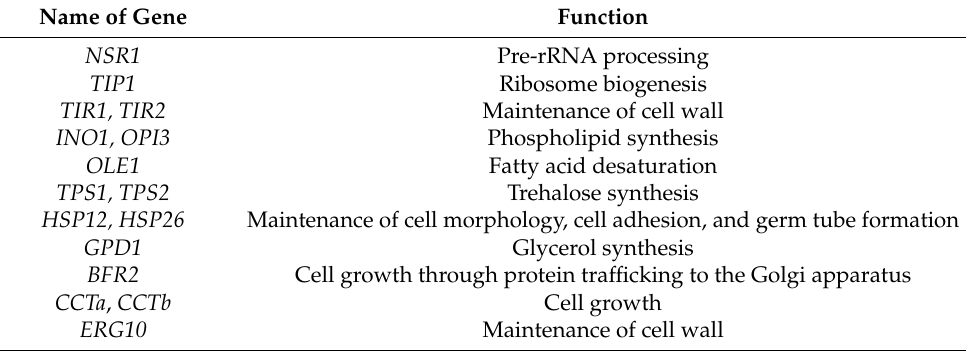
Table 1. The most common genes related to cold response in Saccharomyces cerevisiae yeast [81–86]. Name of